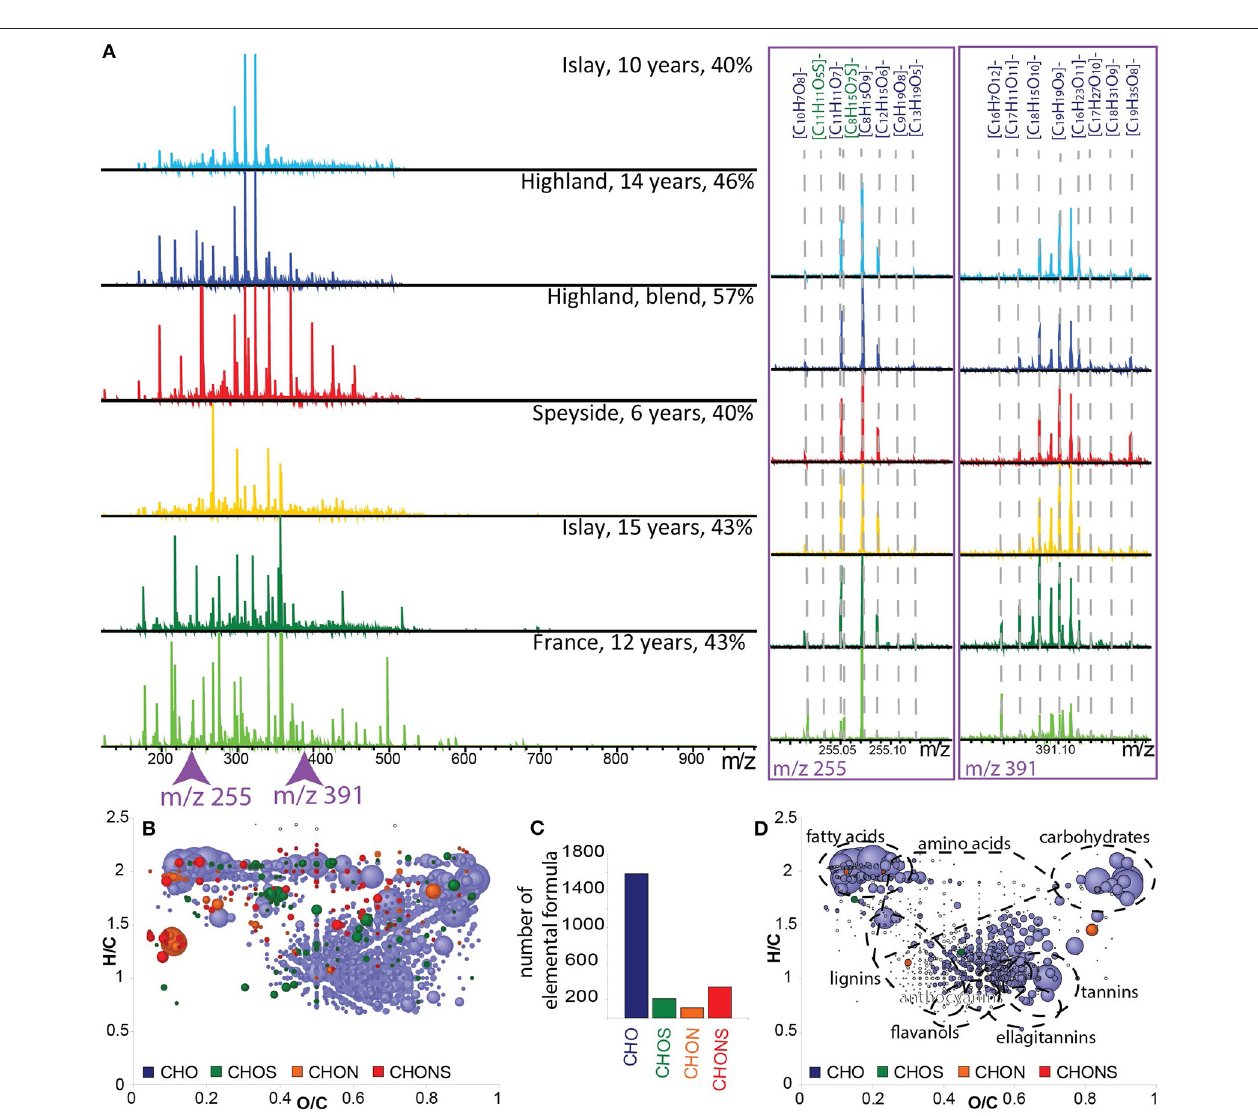
FIGURE 1 | (A) Visualization of ESI(-) FT-ICR-MS spectra of six Whisky samples from various geographical origins, aging time in barrel and alcoholic strengths (% v/v), in the mass range from 100–1,000 Da together with enlargements of the nominal masses m/z 255 and m/z 391 showing the molecular formula assignments. (B) Van Krevelen diagram (H/C vs. O/C) of the global composition of 150 whisky samples. (C) Frequency histogram of CHO, CHOS, CHON, and CHONS elemental compositions displayed in (B) . (D) Van Krevelen diagram showing the 791 annotated metabolites from our home-built database. Points in van Krevelen diagrams are colored according to their elemental composition, CHO in blue, CHOS in green, CHON in orange, and CHONS in red, and scaled according to their peak